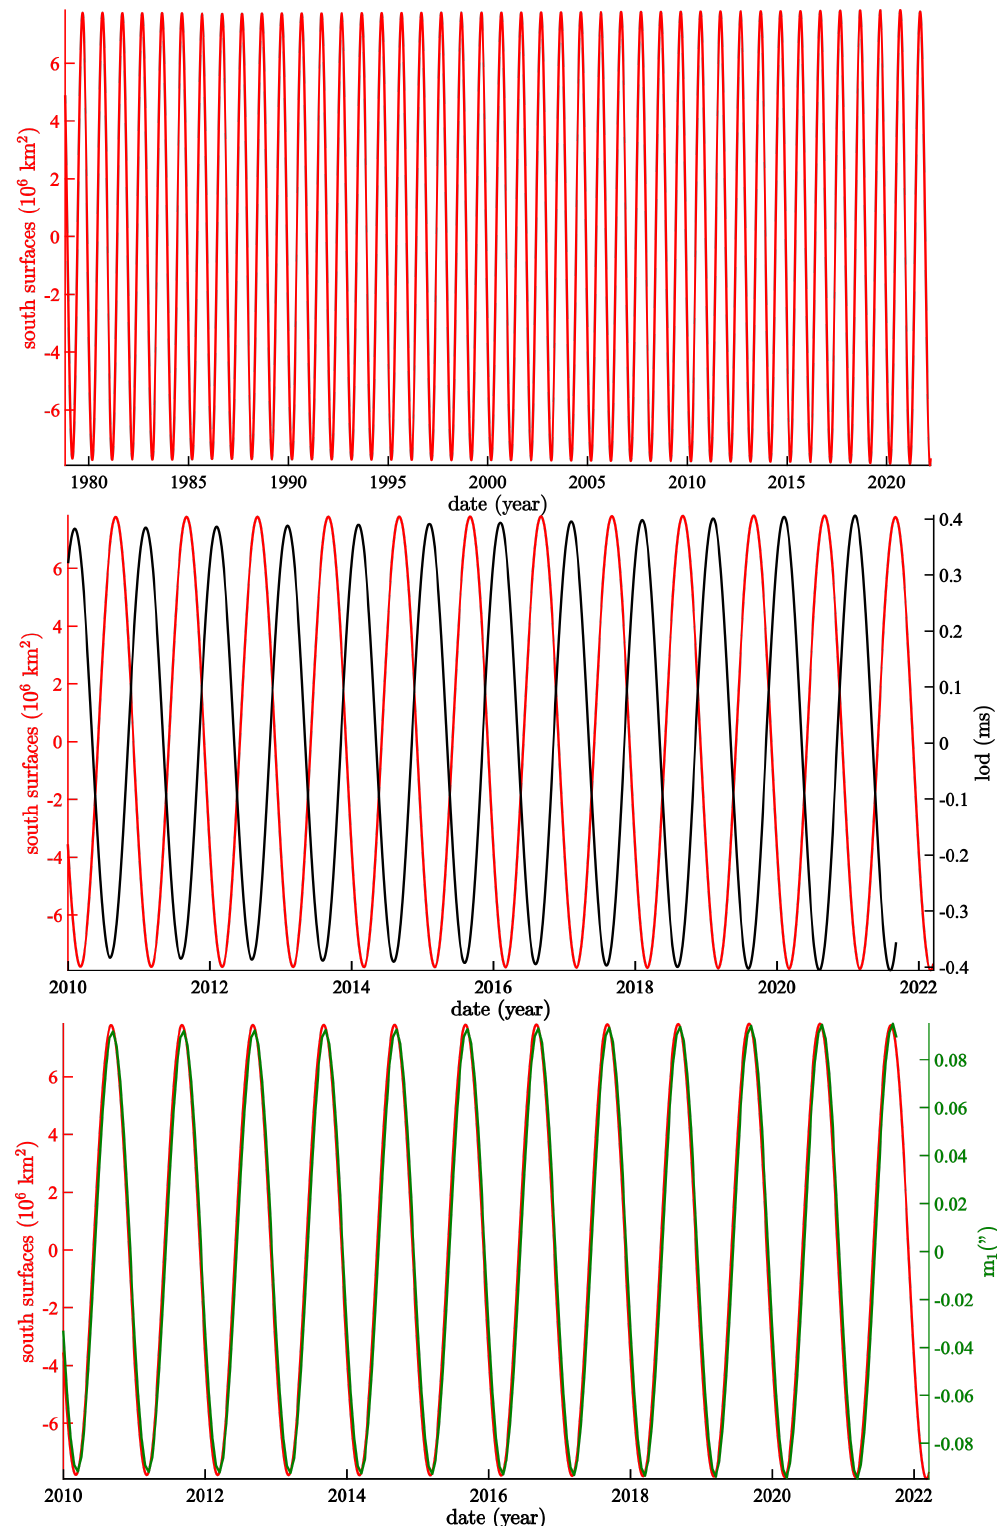
Figure 8. Comparison of SSA annual components of pole motion m 1 ( bottom , in arc seconds) and lod ( top and middle enlargement, in ms) with that of SHSI (Antarctic sea-ice, in 10 6 km 2 ): top = 1978–2022; middle and bottom =